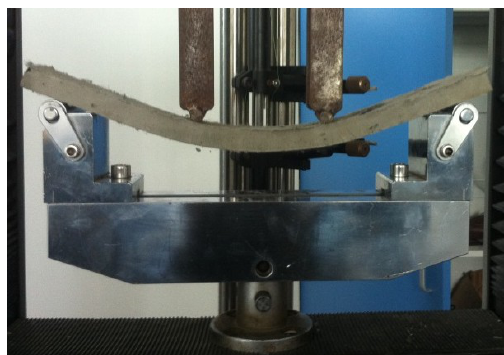
Figure 12. Typical deformation of specimen under bending.